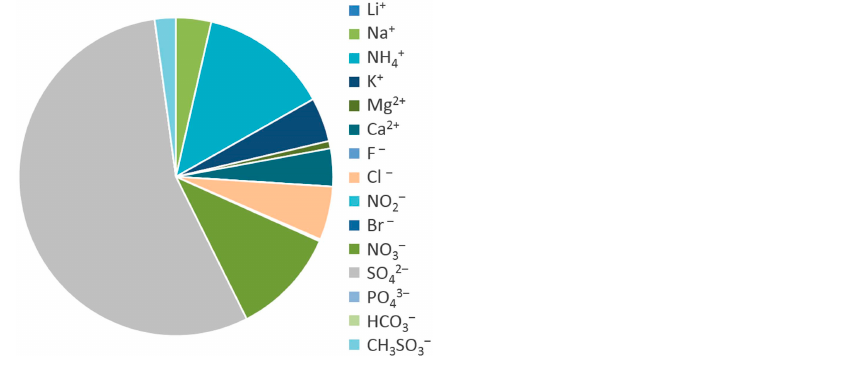
Figure 11. Component composition of atmospheric aerosols in the settlement of Turka, 7–8 August 2020.